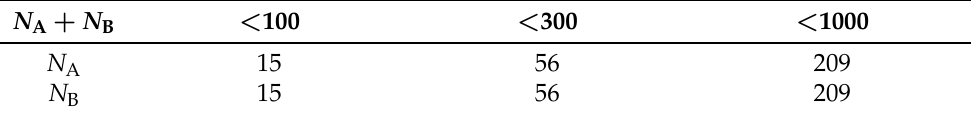
Table 1. Turns number for shift angle equal to 30 ◦ (conversion values).